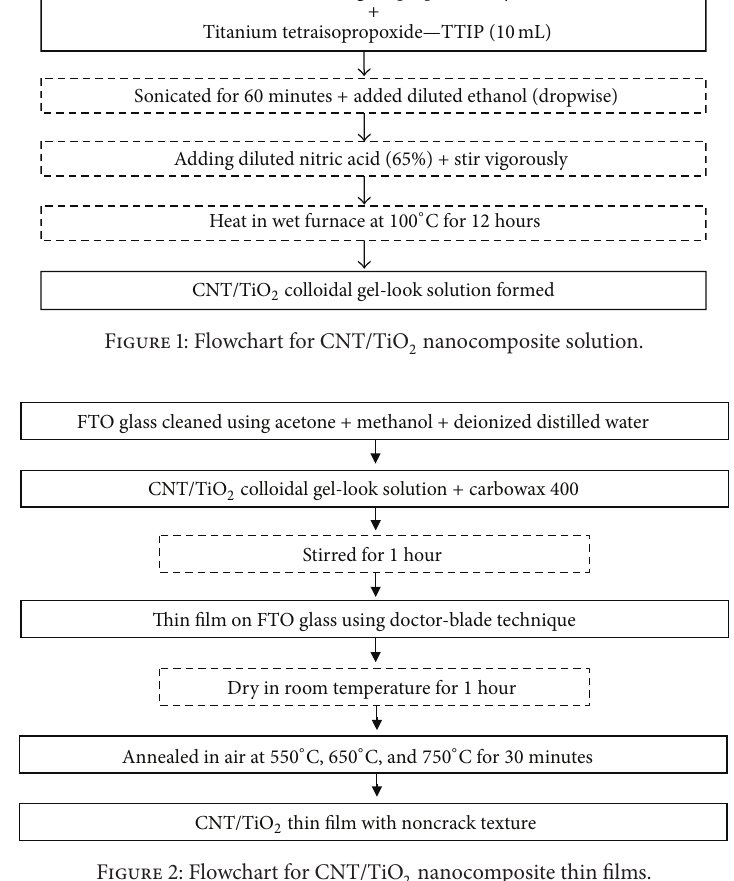
Figure 2: Flowchart for CNT/TiO 2 nanocomposite thin